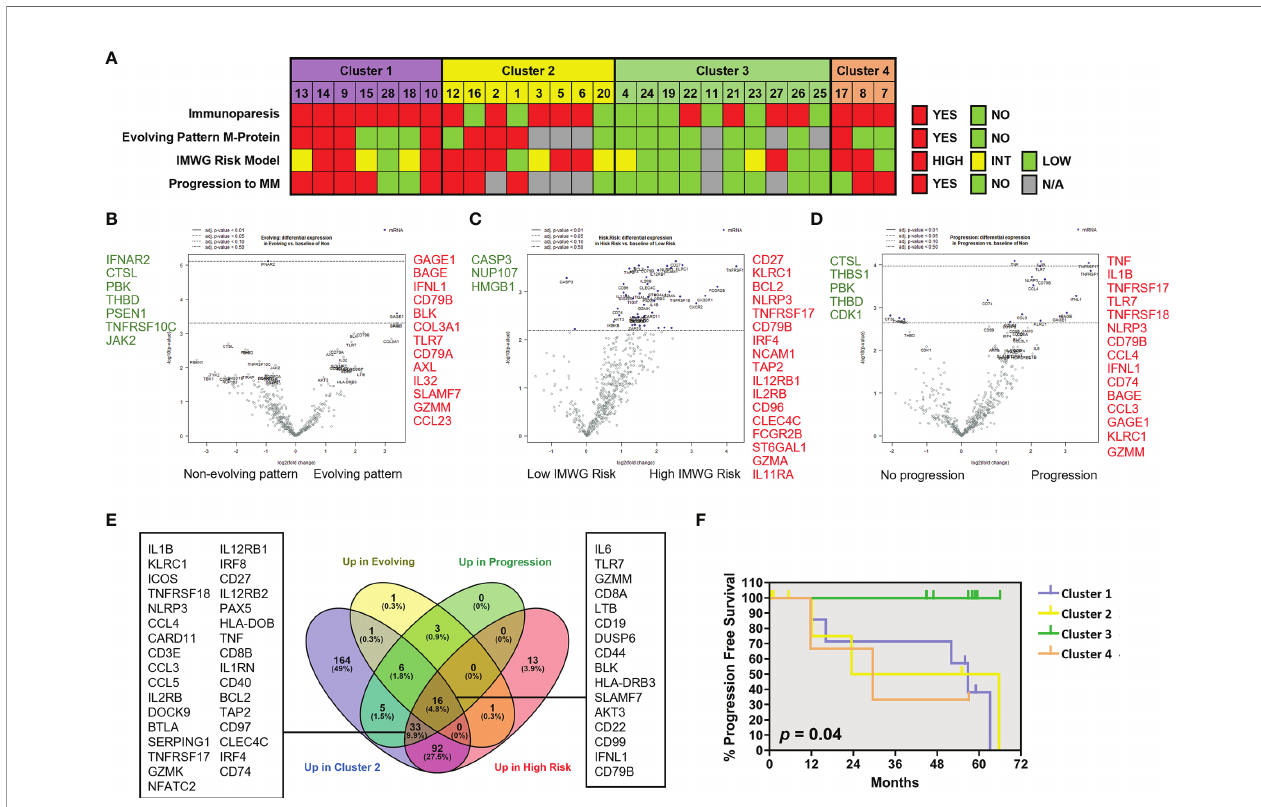
FIGURE 5 | Patients with SMM with cytotoxic immune signature showed high-risk characteristics. (A) Clinical characteristics in patients with SMM divided into 4 clusters according to the results of the unsupervised hierarchical clustering using the PanCancer immune panel. Immunoparesis was de fi ned qualitatively as one or more of uninvolved immunoglobulins below the normal levels. The International Myeloma Working Group (IMWG) SMM revised risk model includes serum M-protein >2 g/dL, involved to uninvolved free light-chain ratio >20 and BMPC in fi ltration >20%. *Patients enrolled in clinical trials were unavailable for determination of the M-protein behavior or progression to symptomatic disease. (B) Volcano plot showing genes differentially expressed in patients with evolving pattern of M-protein. (C) Volcano plot showing genes differentially expressed in patients with high progression risk according to IMWG. (D) Volcano plot showing genes differentially expressed in patients that progress to asymptomatic MM. (E) Venn diagram to assess common upregulated genes in cluster 2 and in patients with higher risk of progression. (F) Kaplan-Maier plot showing progression free survival (PFS) of patients in 4 clusters. Long-rank